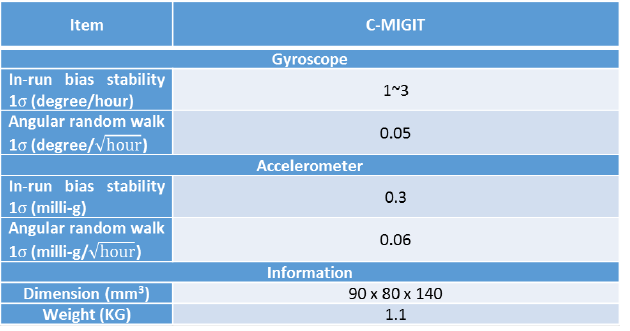
Table 1. Specification of